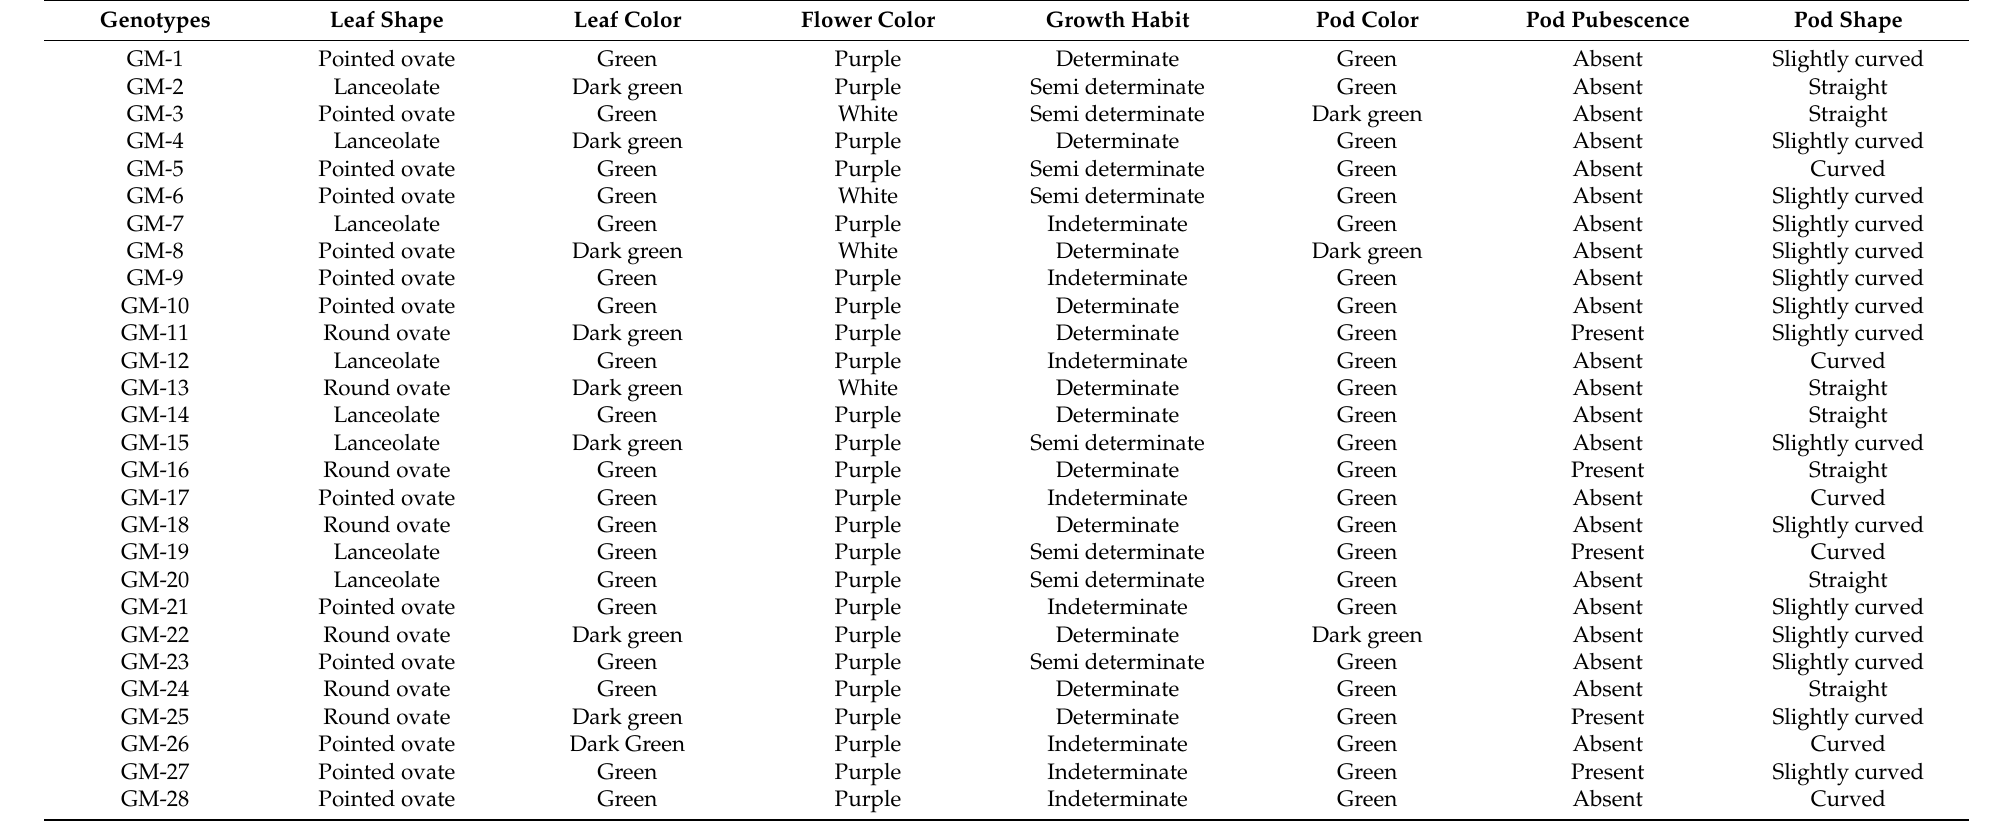
Table 1. The morphological characterization of of vegetable soybean genotypes using soyabean descriptor (IBPGR,